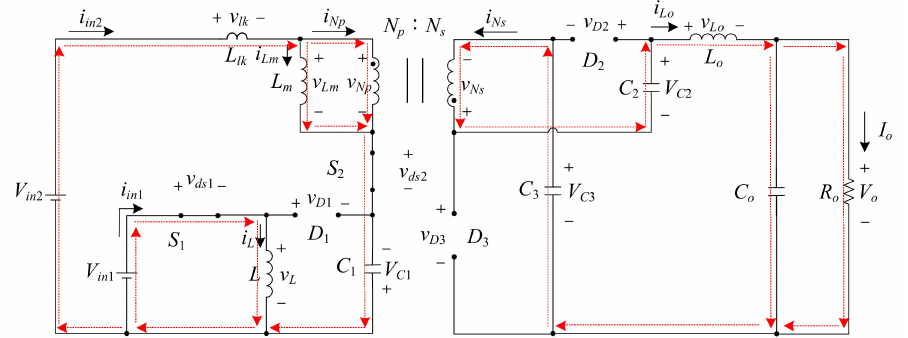
Figure 7. State 1 power flow.